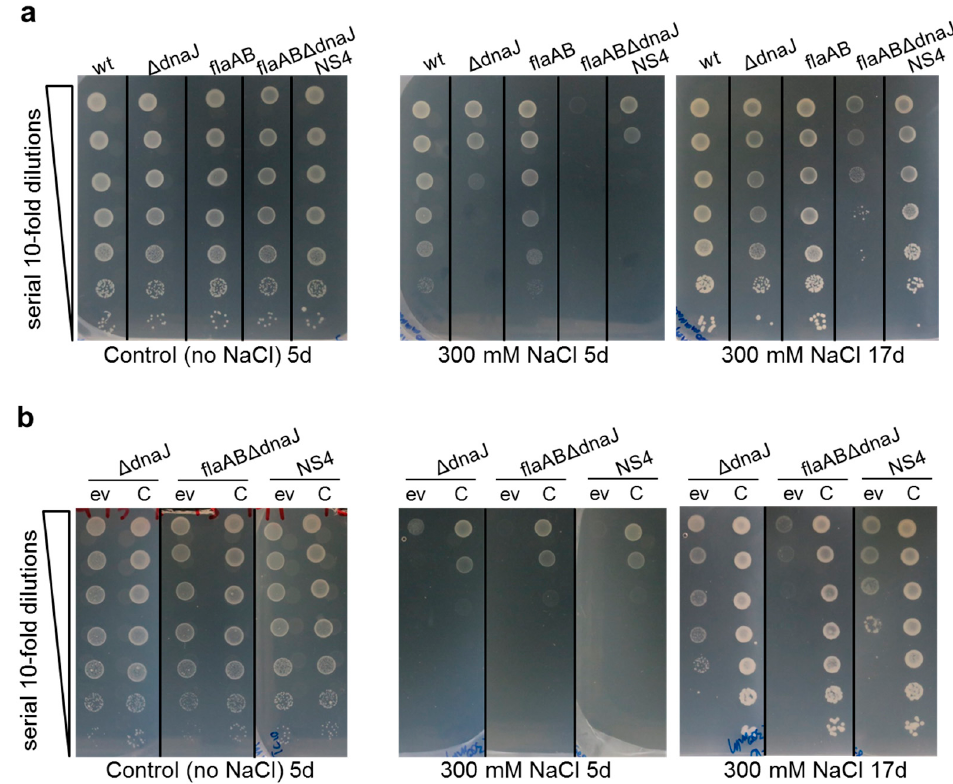
Figure 5. DnaJ loss-of-function in S. meliloti leads to increased sensitivity against salt stress. ( a ) Salt stress tolerance of GR4 (wt) and its dnaJ deletion mutant ( ∆ dnaJ), the flagellaless GR4flaAB (flaAB) and its dnaJ deletion (flaAB ∆ dnaJ), and Tn 5 insertion (NS4) mutants. ( b ) Salt stress tolerance of dnaJ mutants carrying the empty vector (ev) or the dnaJ -expressing plasmid construct (C). Cell suspensions in MM were prepared from mid-log cultures at the same OD 600 , and 10 µ L of 10-fold serial dilutions were spotted on MM agar plates supplemented or not with 300 mM NaCl. Plates were incubated at 28 °C for 5 (5 d) or 17 days (17 d).